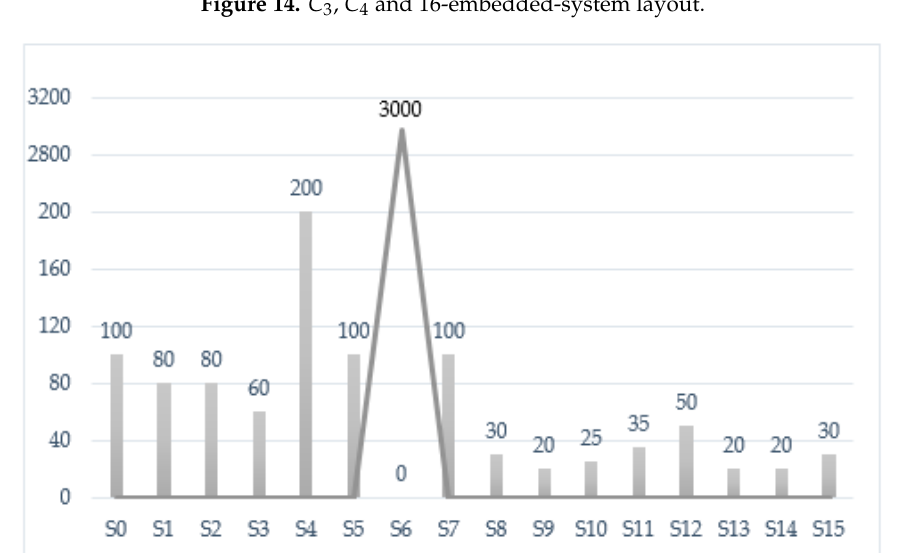
Figure 15. Electromagnetic wave power density for C 3 to S 0 , S 1 , …, and S 15 .